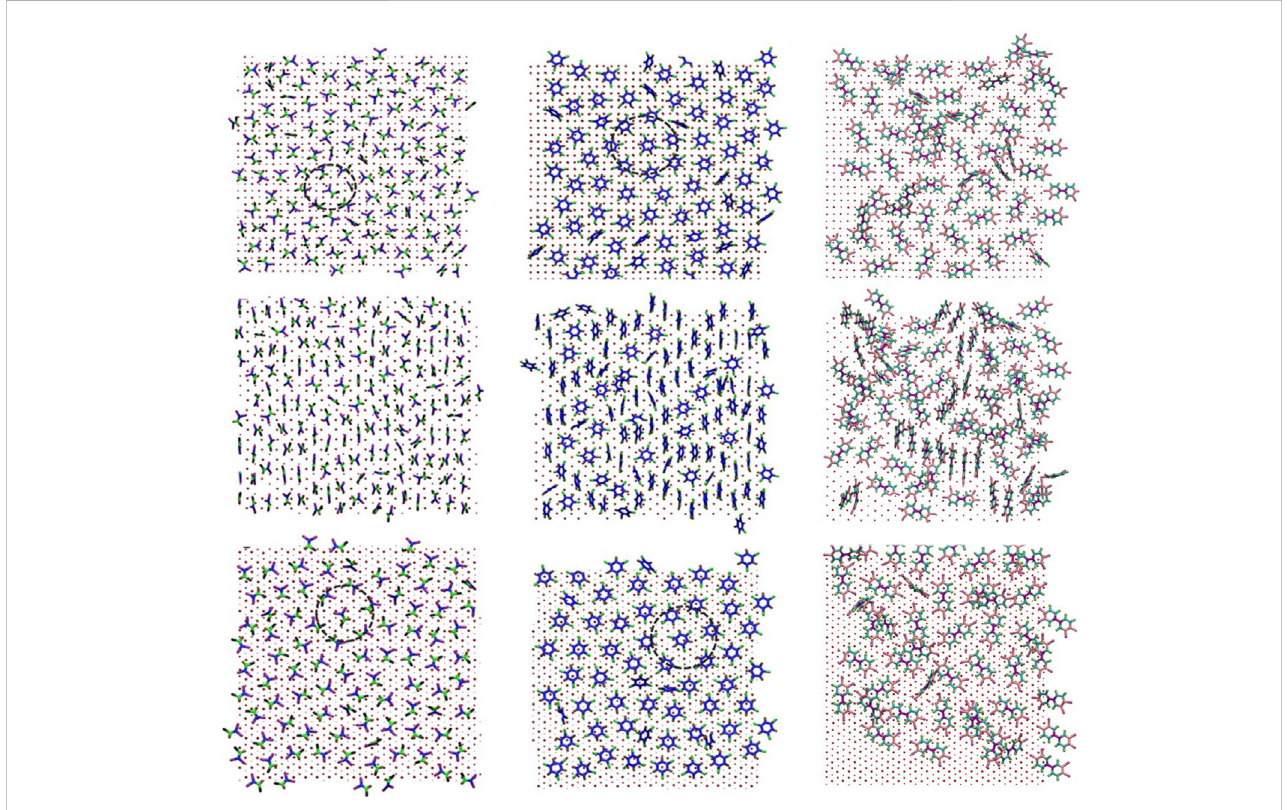
FIGURE 4 Top view snapshot of packing of adsorbate layers for TCE at 230 K (left column), TCB at 360 K (middle column) and PCB77 at 500 K (right column) for three facets: Pd {100} (top row) Pd {110} (middle row) and Pd {111} (bottom row). The color scheme is the same as in Figure 2. Black circles represent example patches of hexagonal packing. Enlarged snapshots for PCB77 molecules are also shown in Supplementary Figure S3.